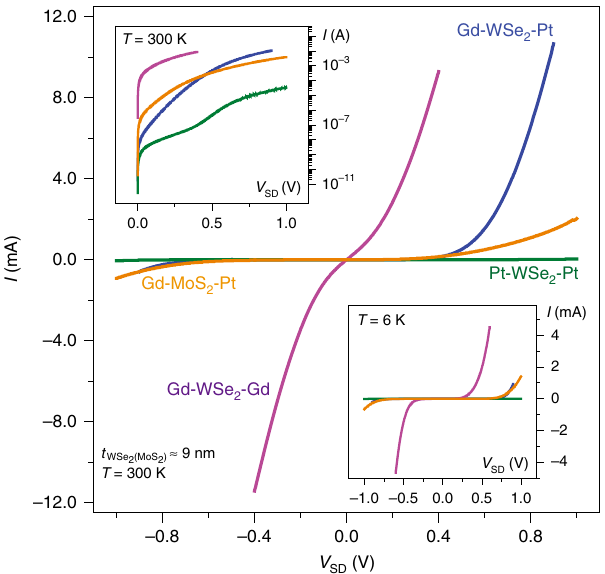
Fig. 4 Vertical heterojunctions with symmetric vs. asymmetric metal contacts. I vs. V SD curves at T = 300 and 6 K (lower inset) from the WSe 2 (blue) and MoS 2 (orange) vertical heterojunctions with asymmetric metal contacts of Pt and Gd. Vertical WSe 2 junctions with symmetric metal contacts of either Pt or Gd are plotted with green (Pt – WSe 2 – Pt) and purple (Gd – WSe 2 – Gd) lines. The thickness of the WSe 2 and MoS 2 fi lms is around 9 nm ( ≈ 14L). (Upper inset) I vs. V SD characteristics at forward bias in log – log scale at T = 300 K, highlighting the distinctions in I – V SD curves in value among the vertical heterojunctions with different metal – 2D vdW contact con fi